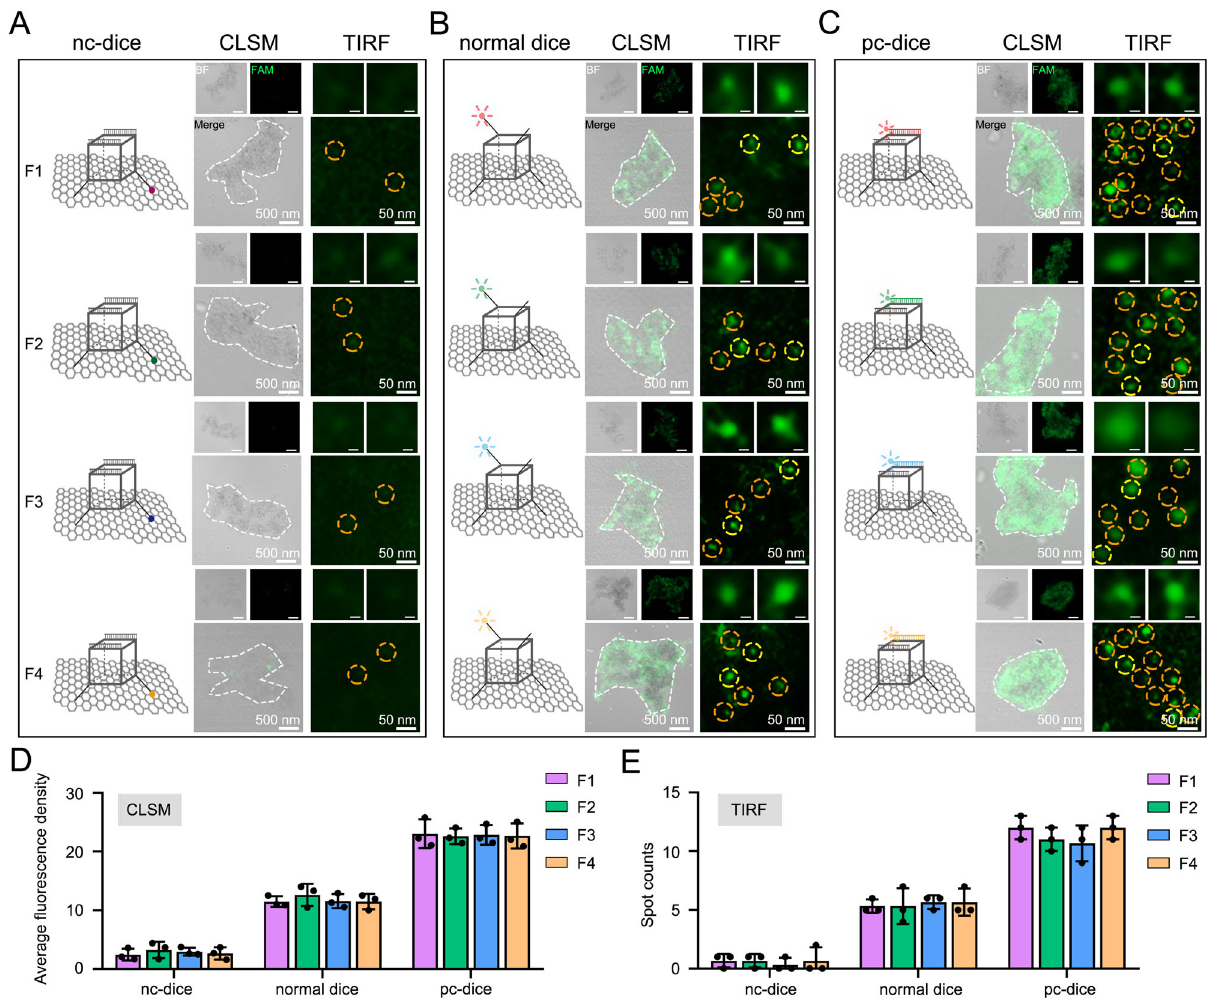
Fig. 4 | The fl uorescence imaging characterization of DNA nano-dice system. A Confocal images (left) and single-molecule images (right) of four signals in nc- dice with GO. The scale bars are 500nm in split and merge CLSM images (left), 50nm in original TIRF images and 10nm in enlarged TIRF images (right), respec- tively. B Confocalimages(left)andsingle-moleculeimages(right)offoursignalsin normal dice with GO. The bright spots in yellow circle were enlarged to show. The scalebarsare500nminsplitandmergeCLSMimages(left),50nminoriginalTIRF images and 10nm inenlargedTIRF images (right), respectively. C Confocalimages